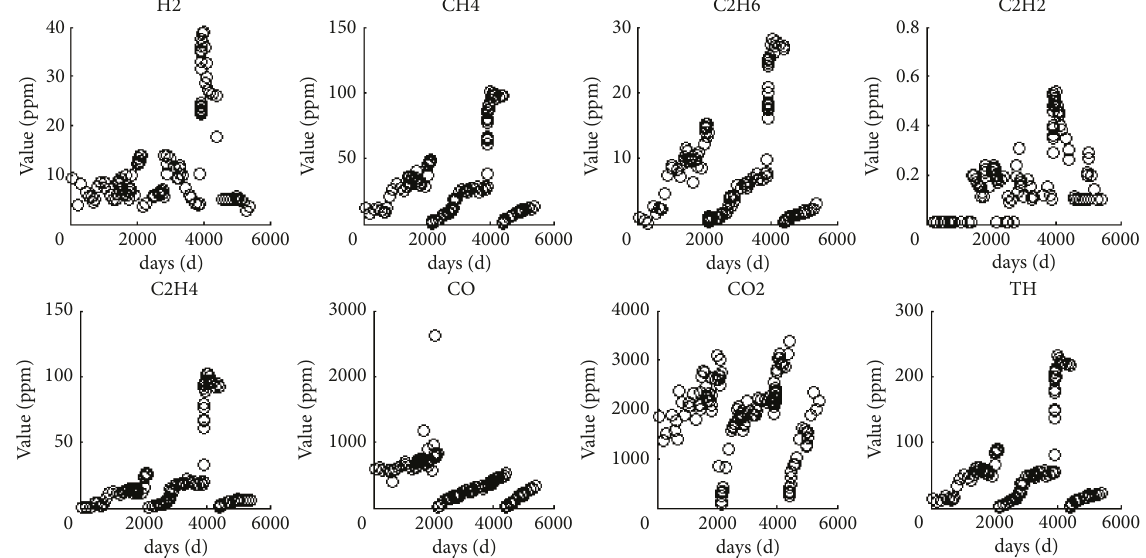
Figure 3: DGA inspection data of a main transformer phase